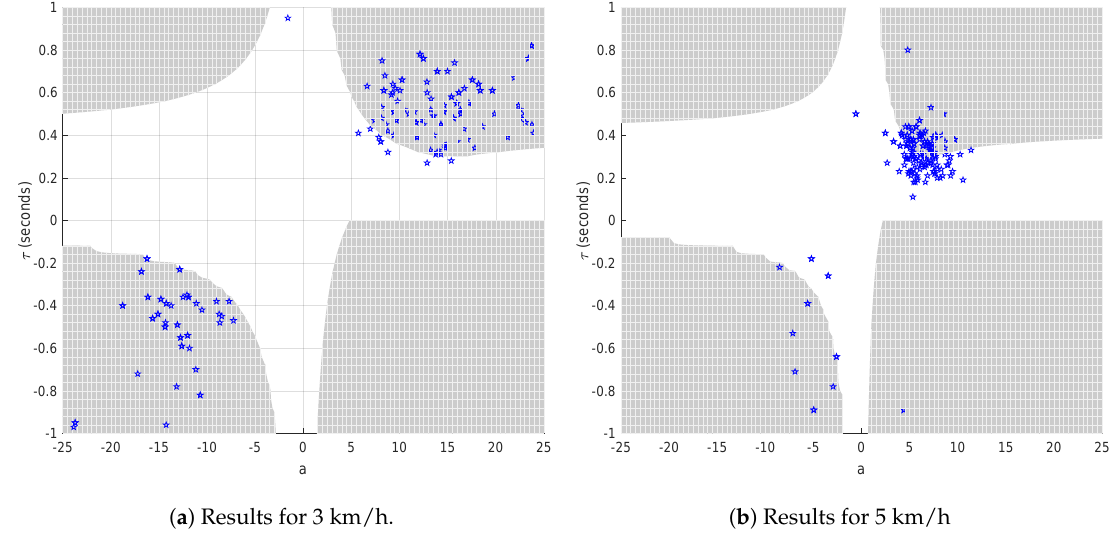
Figure 7. Validation of theoretical results from experiments.